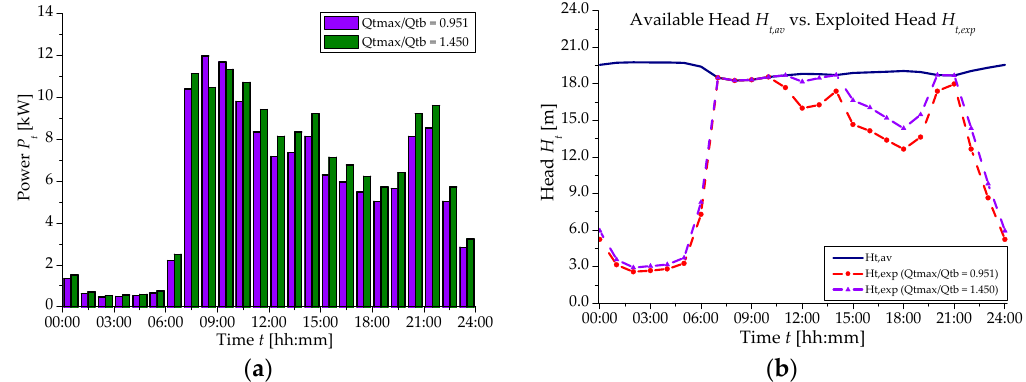
Figure 2. ( a ) Produced power P t ; ( b ) Comparison between available head H t,av and exploit one H t,exp —Scenario